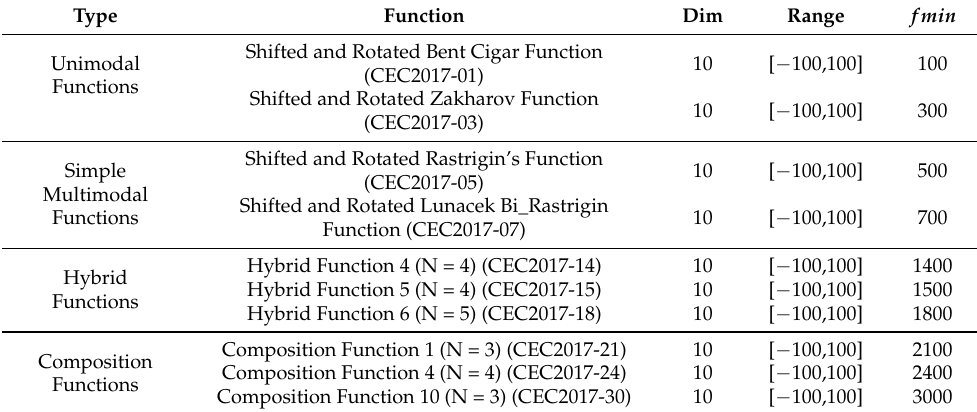
Table 4. The CEC2017 benchmark functions selected for the